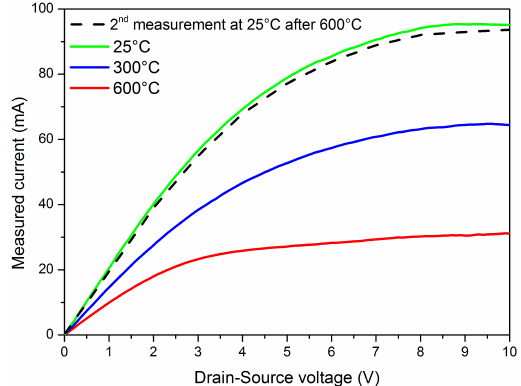
Figure 7. I ds – V ds characteristics of Pt-AlGaN/GaN HEMTs in N 2 for different operating